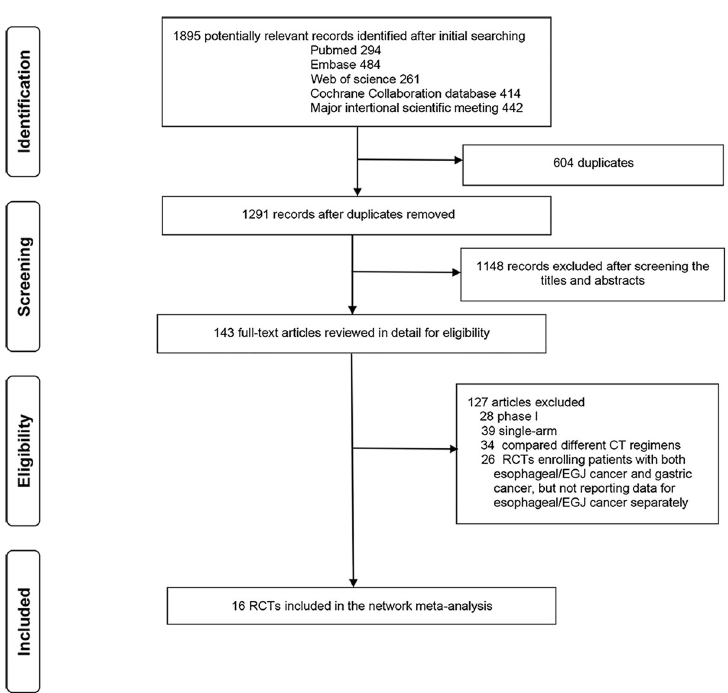
Fig 1. Literature search and selection. RCTs, randomized control trials; EGJ, esophagogastric junction.